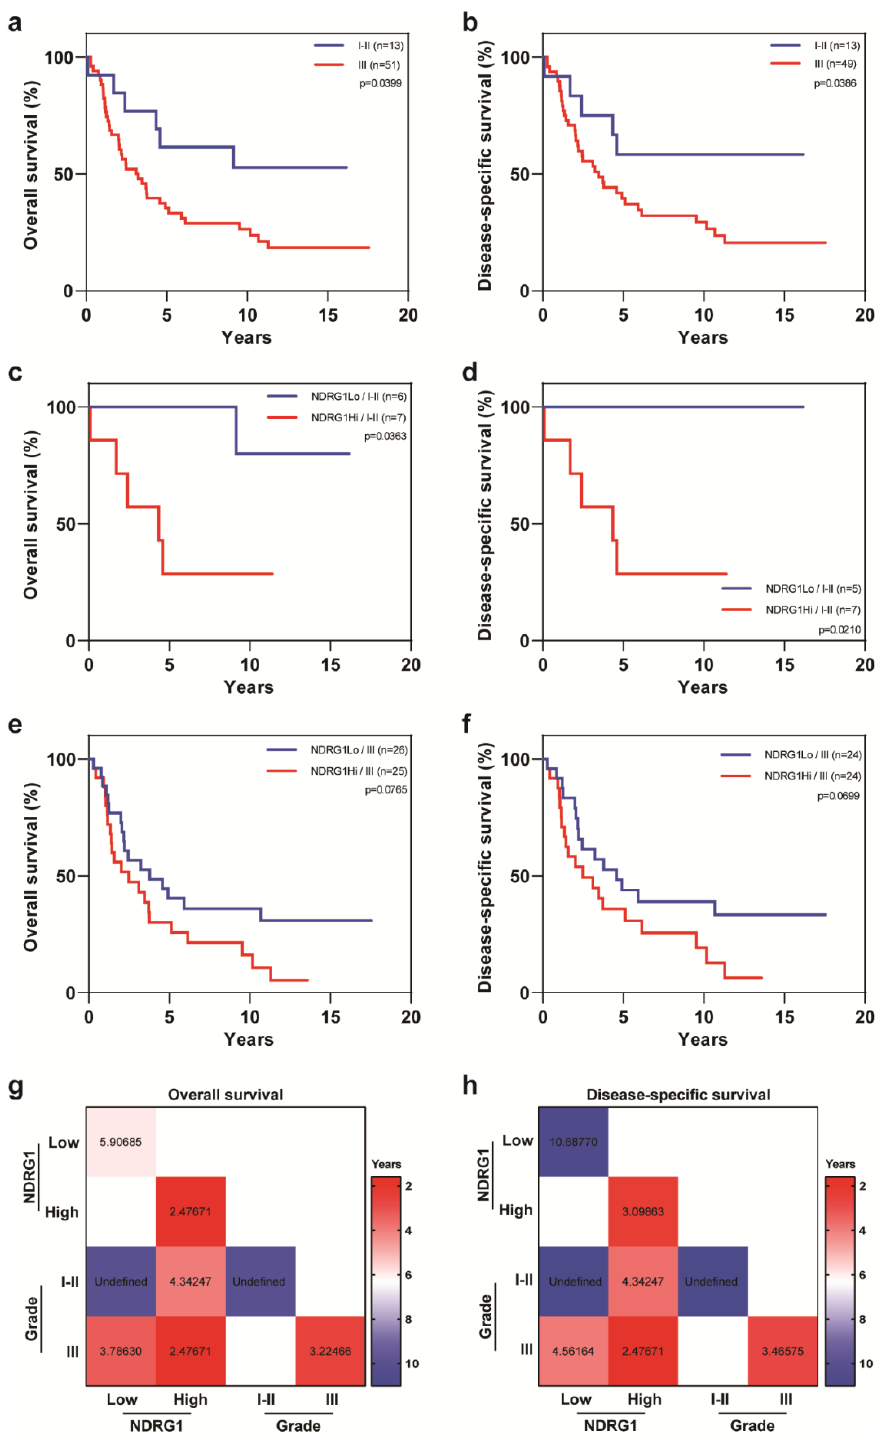
Figure 6. Overall survival and disease-specific survival in patients with IBC stratified by tumor grade and NDRG1 expression. Patients with IBC and low-grade cancer had better ( a ) overall survival and ( b ) disease-specific survival than did patients with grade III disease. ( c , d ) Patients with low-grade IBC stratified by NDRG1 expression in terms of overall survival and disease-specific survival. ( e , f ) Patients with high-grade IBC stratified by NDRG1 expression in terms of overall survival and disease-specific survival. Log-rank tests were used to obtain p values. ( g , h ) Median overall survival and disease-specific survival times, in years, for patients stratified by NDRG1 expression and tumor grade.